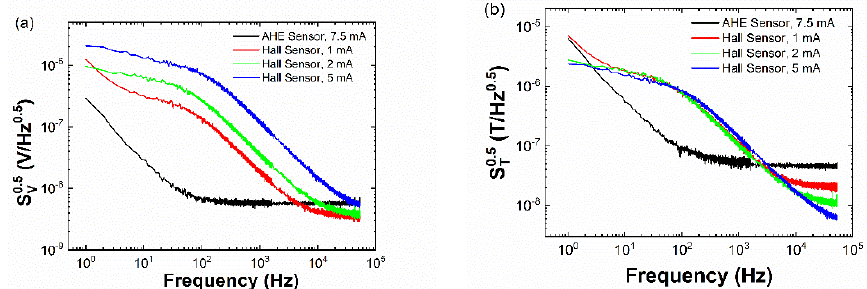
Figure 5. Comparison of the ( a ) voltage noise spectra and ( b ) field detectability spectra between the 30 nm thick Fe 29 Pt 71 anomalous Hall effect (AHE) sensor and a commercial semiconductor Hall sensor.